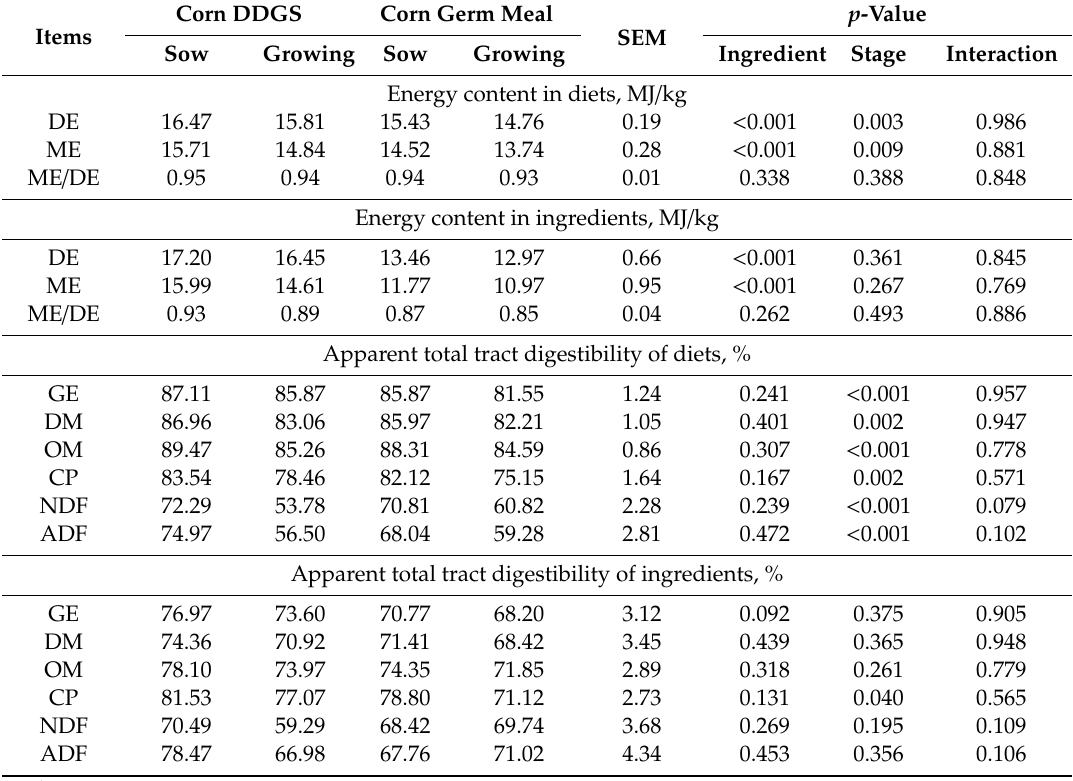
Table 5. Comparative energy and nutrient utilization in medium protein medium fiber (MPMF) diets and ingredients by adult sows and growing pigs 1 (dry matter